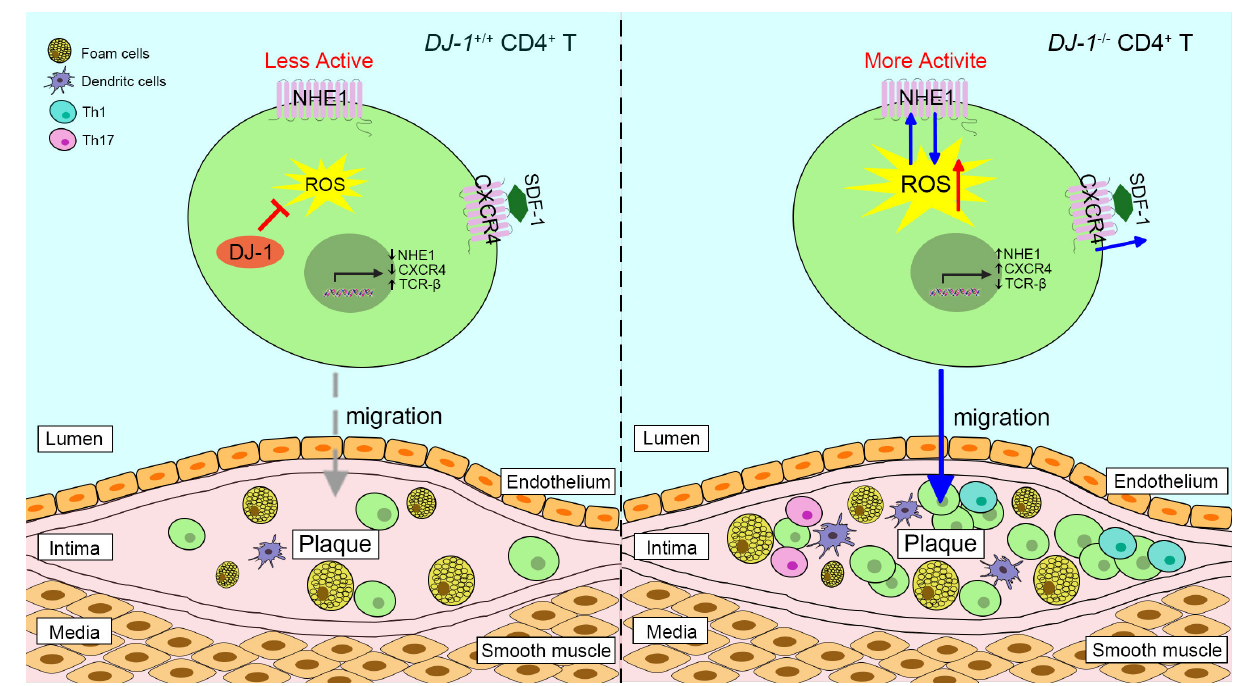
FIGURE 3 | Proposed scheme of the role of DJ-1 in atherosclerosis plaques progression. Absence of DJ-1 leads to excess ROS, which could promote the expression and activity of NHE1 as well as the activity of CXCR4 in response to SDF-1, thus driving CD4 + T cell migration and infiltration into intima. In addition, DJ-1-deficient CD4 + T cells are prone to differentiate into pro-inflammatory Th1 and Th17 phenotypes. Therefore, lack of DJ-1 contributes to atherosclerosis plaque progression. NHE1, Na + /H + exchanger 1; CXCR4, chemokine receptor 4; SDF-1, stromal cell-derived factor